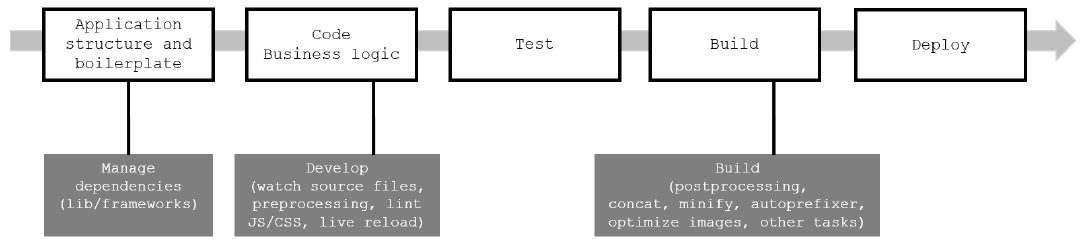
Figure 3. Web application’s development